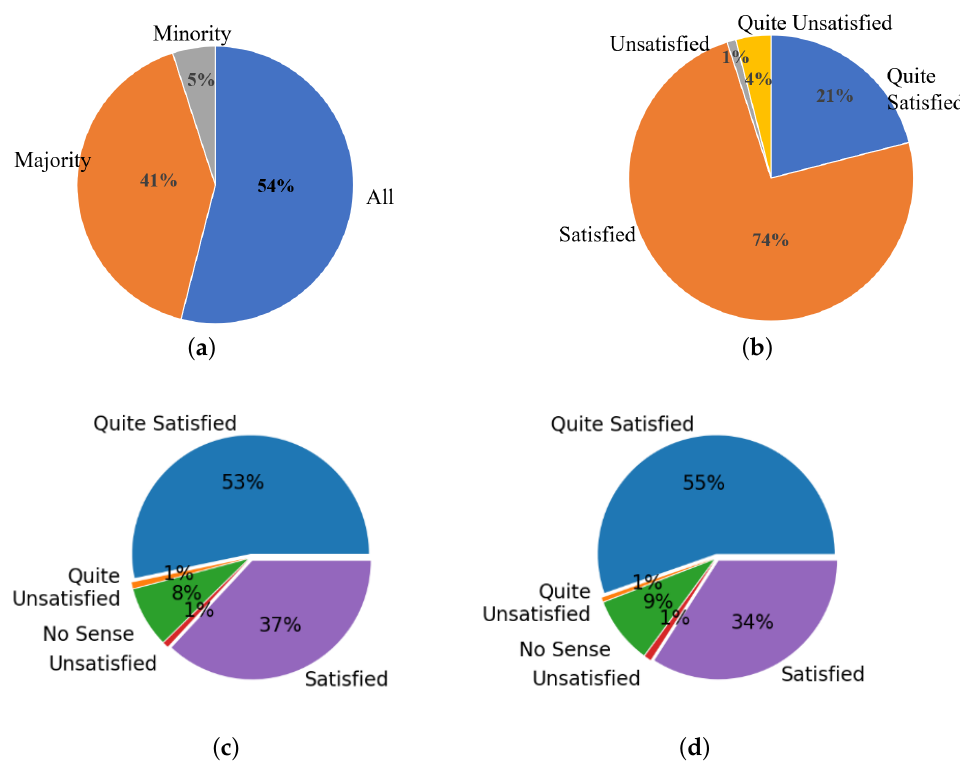
Figure 1. Students’ satisfaction with teachers. Satisfaction with ( a ) the teaching quality, ( b ) the use of resources, ( c ) the guidance, and ( d ) correcting homework.